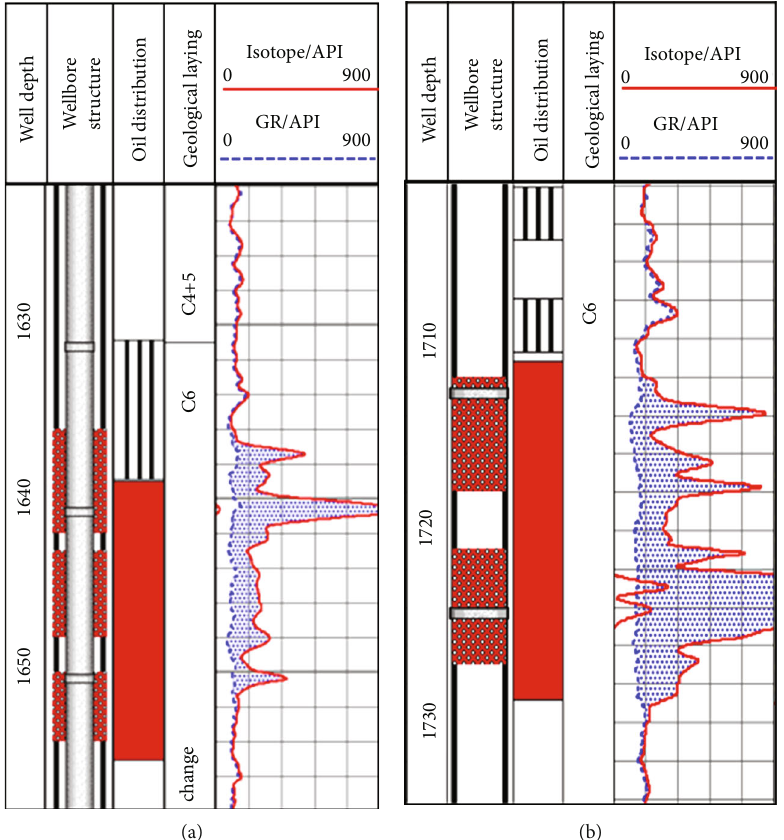
Figure 6: Typical nonuniform absorption pro fi le of water injection wells in this block. (a) Peaking water absorption. (b) Fingering water